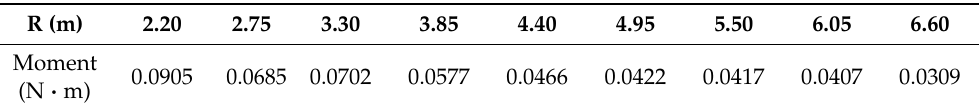
Figure 10. Change of moment with respect to angular velocities in rotating arm test simulation. Table 6. Numerical results of the rotating arm test simulation of the underwater vehicle model at various radii when the inlet velocity is 0.5